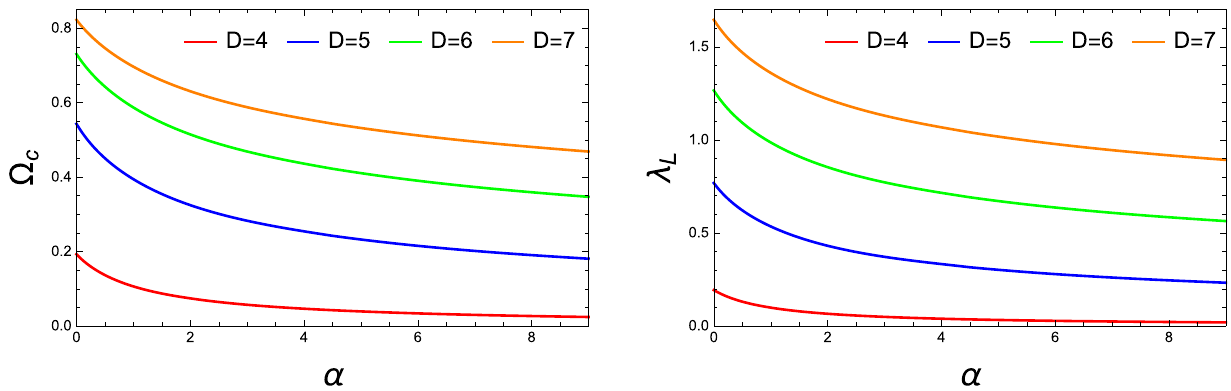
Fig. 4 The angular velocity (cid:9) c and the Lyapunov exponent λ L with respect to the parameter α , where the spacetime dimension is taken to be D = 5 , 6 , 7, respectively, and the case of D = 4 is attached for comparison. Here we set M =